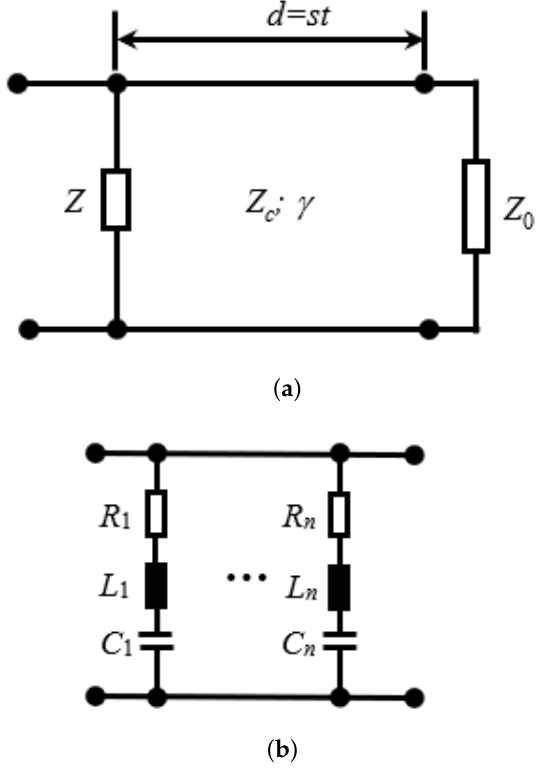
Figure 6. Equivalent circuits: ( a ) unit cell; ( b ) impedance Z